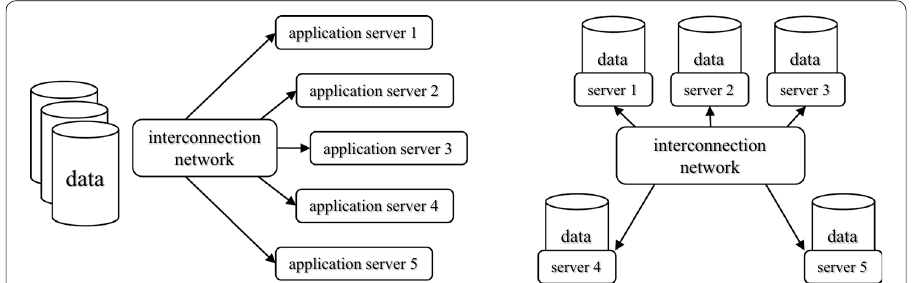
Fig. 1 “Data move to process” and “move process near data”